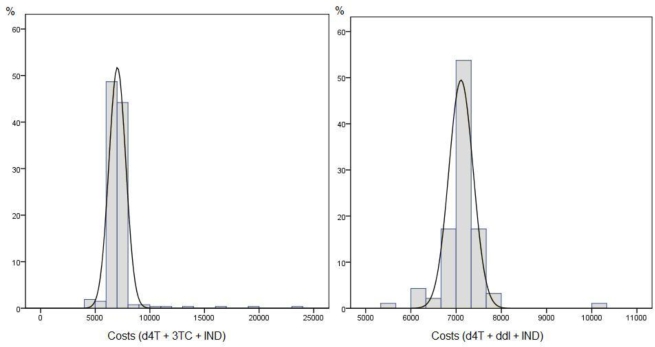
Histogram of costs.